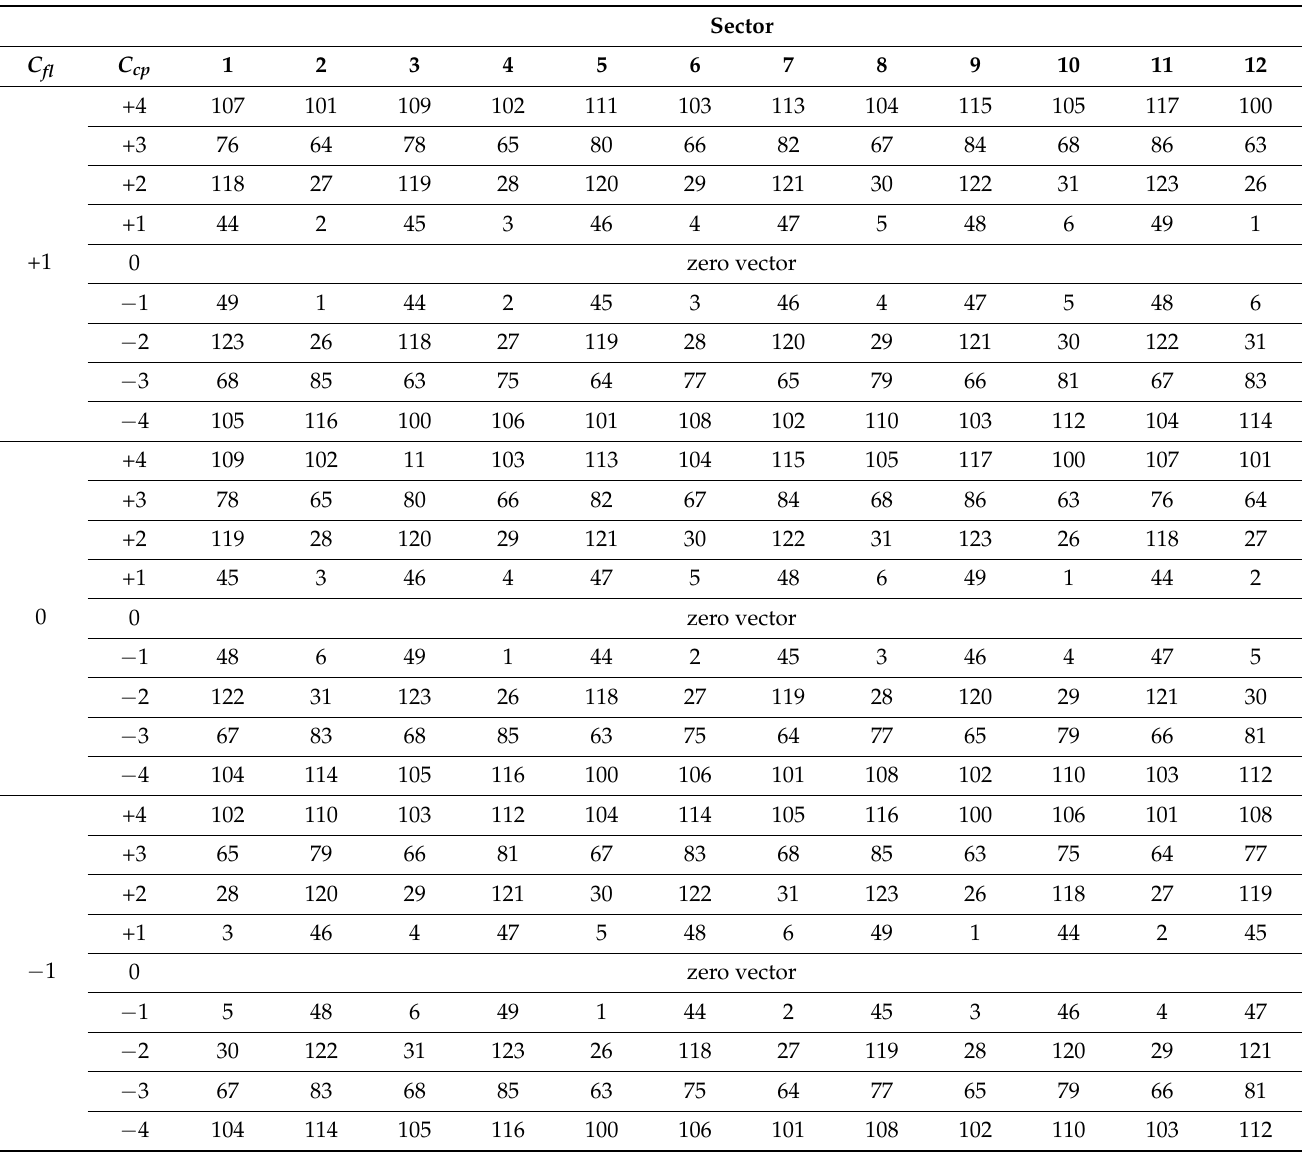
Table 2. Switching table of five-level